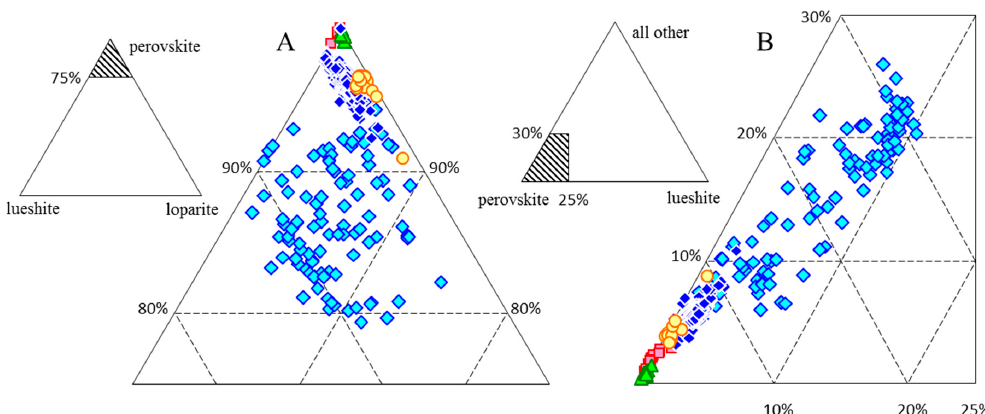
Figure 8. Compositional fields (mol%) in the ternary systems that include the recommended [31] lueshite–perovskite–loparite end-members ( A ) and all end-members ( B ): Symbols as in Figure 7. Table 2. Selected analyses of perovskites of the Tazheran Unlike these, perovskites from the skarn-related Fo-Spl calc–silicate rocks of site 4 are less homogeneous and have relatively high impurity contents (Fe, Na, REE, Nb, and Th), while the range of U contents is narrow. Early perovskites are more homogeneous and contain lesser amounts of impurities, but late varieties show large ranges of Fe, Na, REE, Nb, and Th and lower percentages of the perovskite end-member, down to 67% (Figure 8). As shown by calculations of end-members according to Locock and Mitchell [32], the shares of the lueshite, loparite, and REEFeO 3 end-members may reach, respectively, 10.5%, 14%, and 15%, while other end-members are rare to absent. The higher the impurity contents, the more the deviation from the line of constant Ca/Ti (Figure 7).